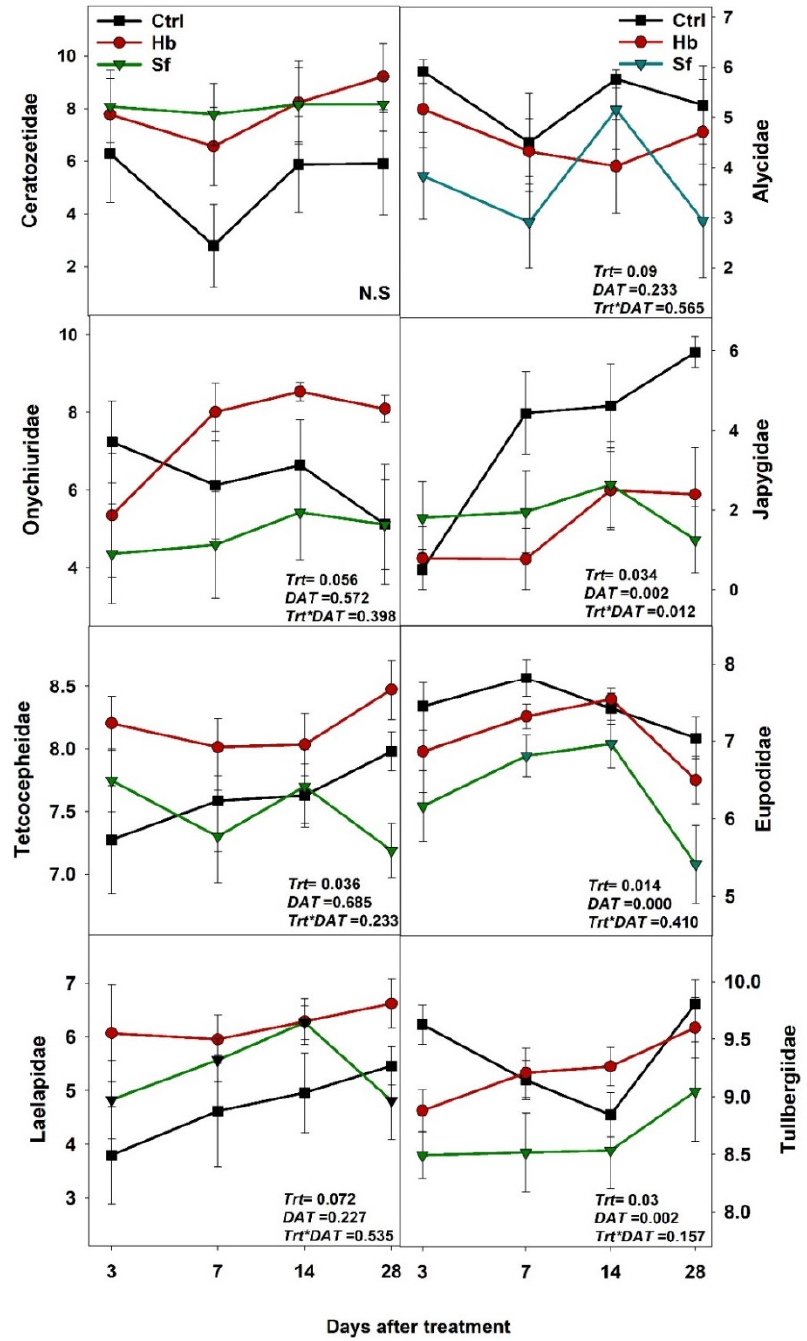
Figure 5. Eight microarthropod family responses to augmentation with Steinernema feltiae (Sf) , Heterorhabditis bacteriophora (Hb) and an untreated control (Ctrl). Plots in the left column exhibit potential predator epidemiology. Plots in the right column depict potential prey of entomopathogenic nematode species.